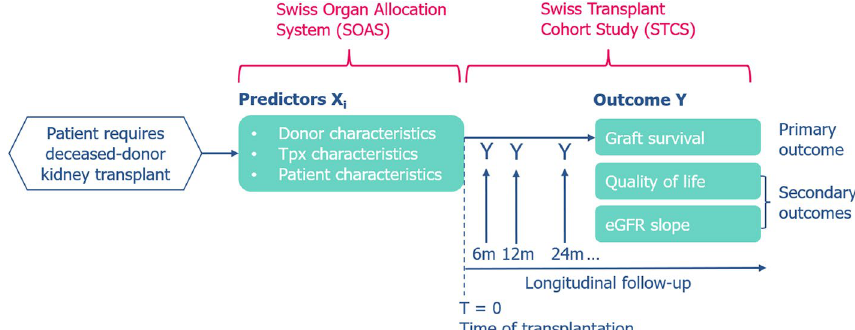
Fig. 1 Schematic overview of the multivariable prediction models and the data sources involved. Three separate models will be developed to predict the three outcomes by a set of predictors. Predictors are based on SOAS data, while mid- and long-term outcomes were collected by a national multi-centre cohort